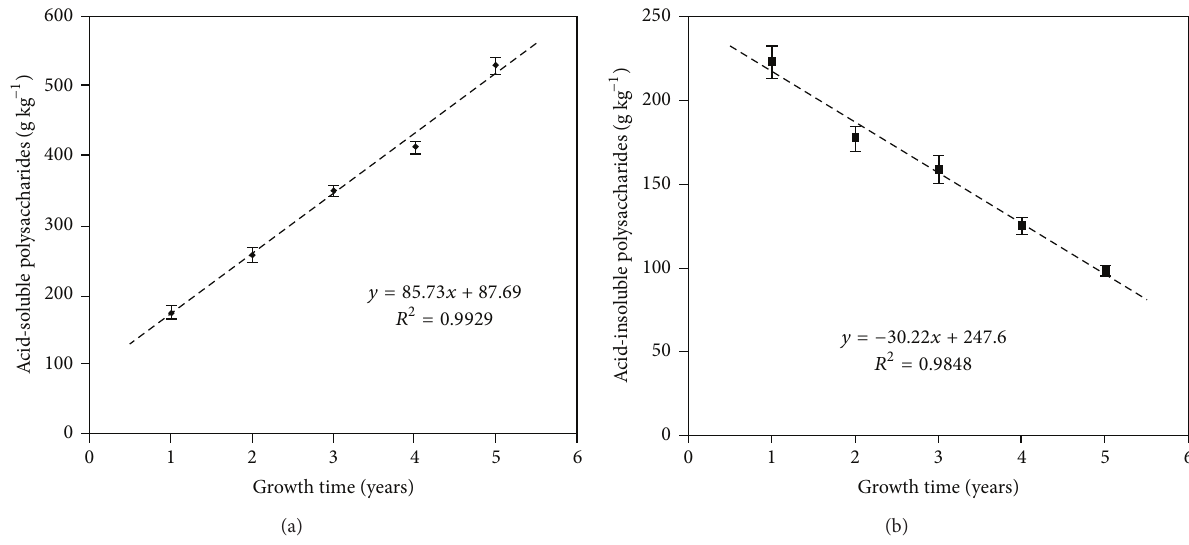
Figure 4: (a) Changes of acid-soluble polysaccharides contents of kudzu root during growth. (b) Changes of acid-insoluble polysaccharides contents of kudzu root during growth. The data were reported as means ± standard